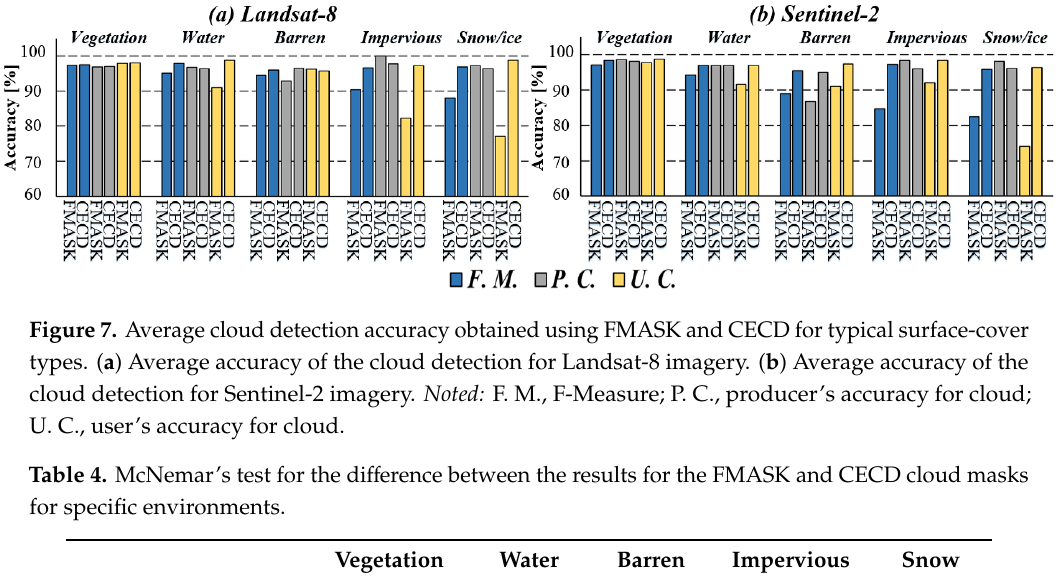
Table 4. McNemar’s test for the difference between the results for the FMASK and CECD cloud masks for specific environments.